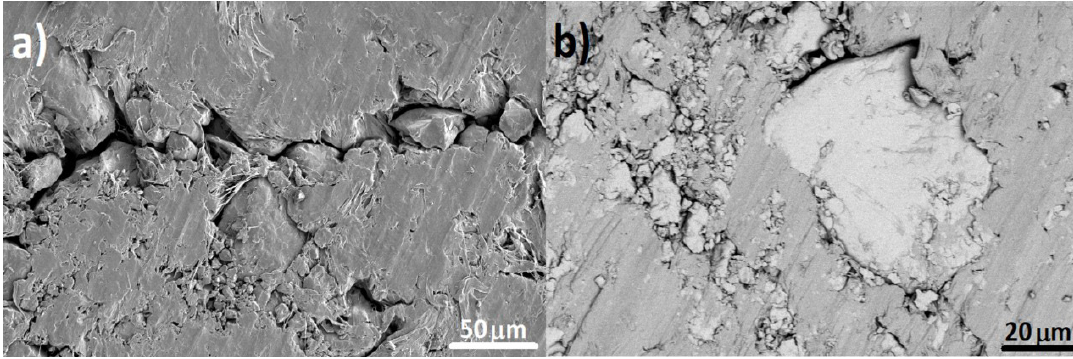
Figure 8. SEM image (BSE mode) of the top cross-section of the UHMWPE-TiFe IMC composite. Magnification of (a) 500x and (b) 1000x.